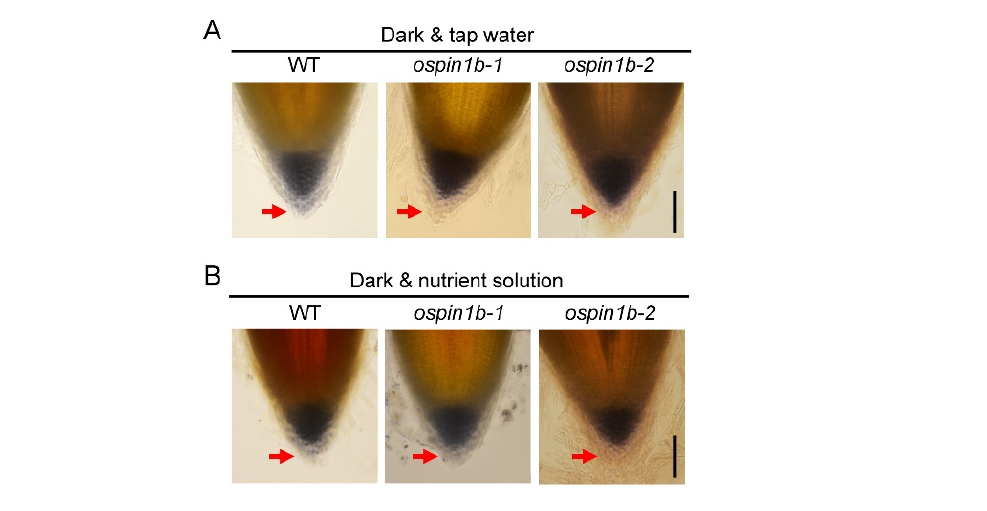
Figure 10. Amyloplast sedimentation analysis in wild-type (WT) and ospin1b root caps. ( A ) Rice plants were cultured with tap water in the dark. ( B ) Rice plants were cultured with a nutrient solution in the dark. The red arrow indicates the peripheral tiers of the root cap columella cell. Bar = 0.1 mm.